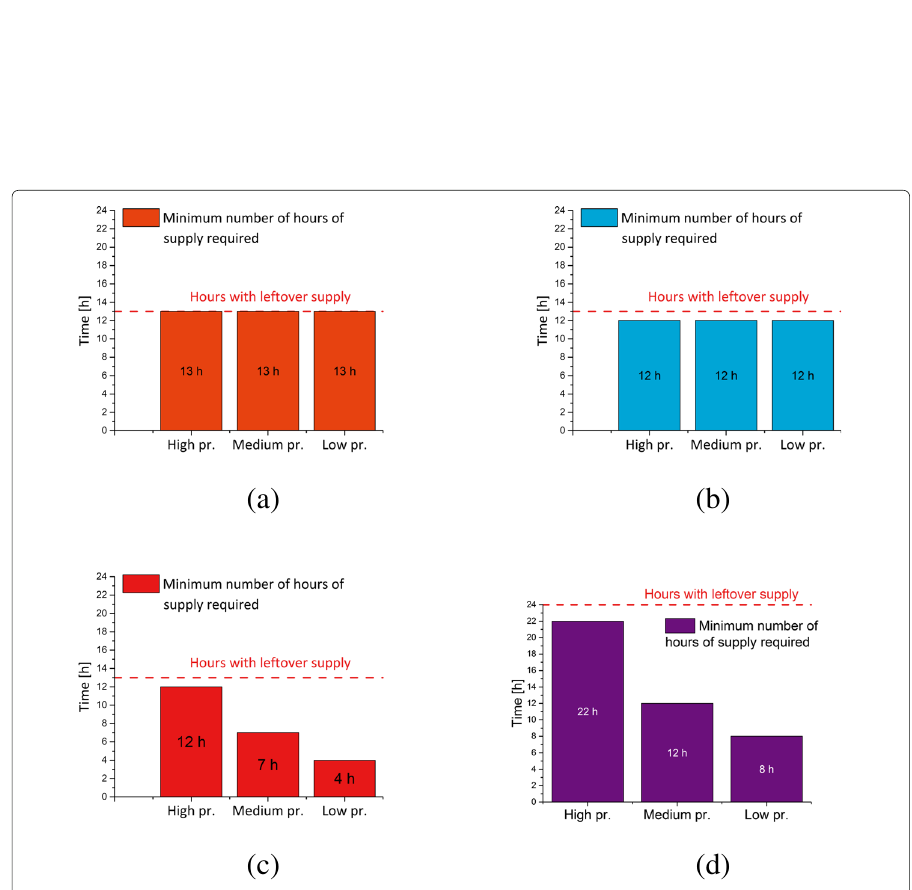
Fig. 7 Minimum required number of hours of supply. a Minimum required number of hours of supply - all priorities require 13 hours of supply, b Minimum required number of hours of supply - all priorities require